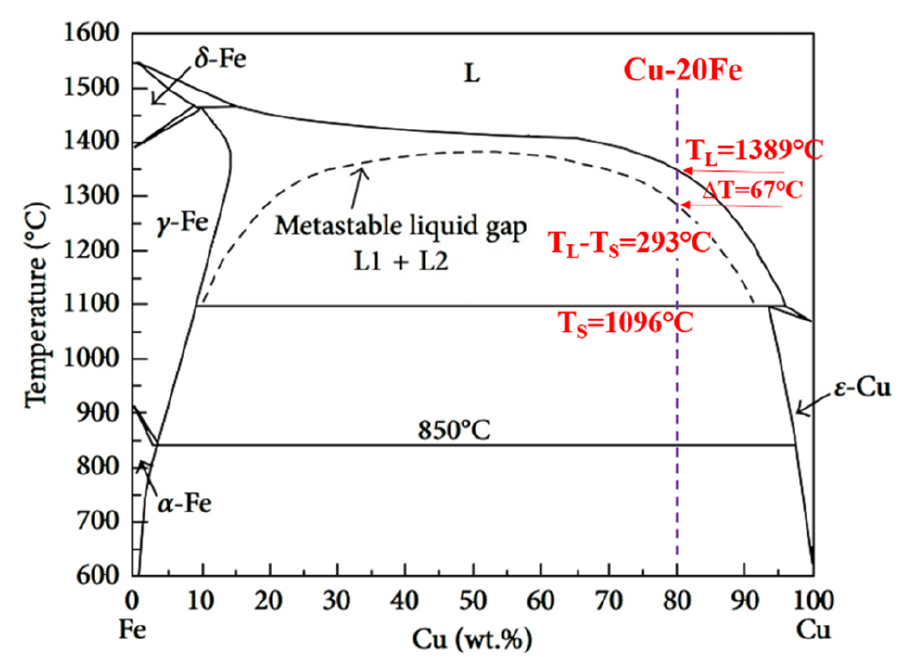
Figure 2. Phase diagram of Cu-Fe system.